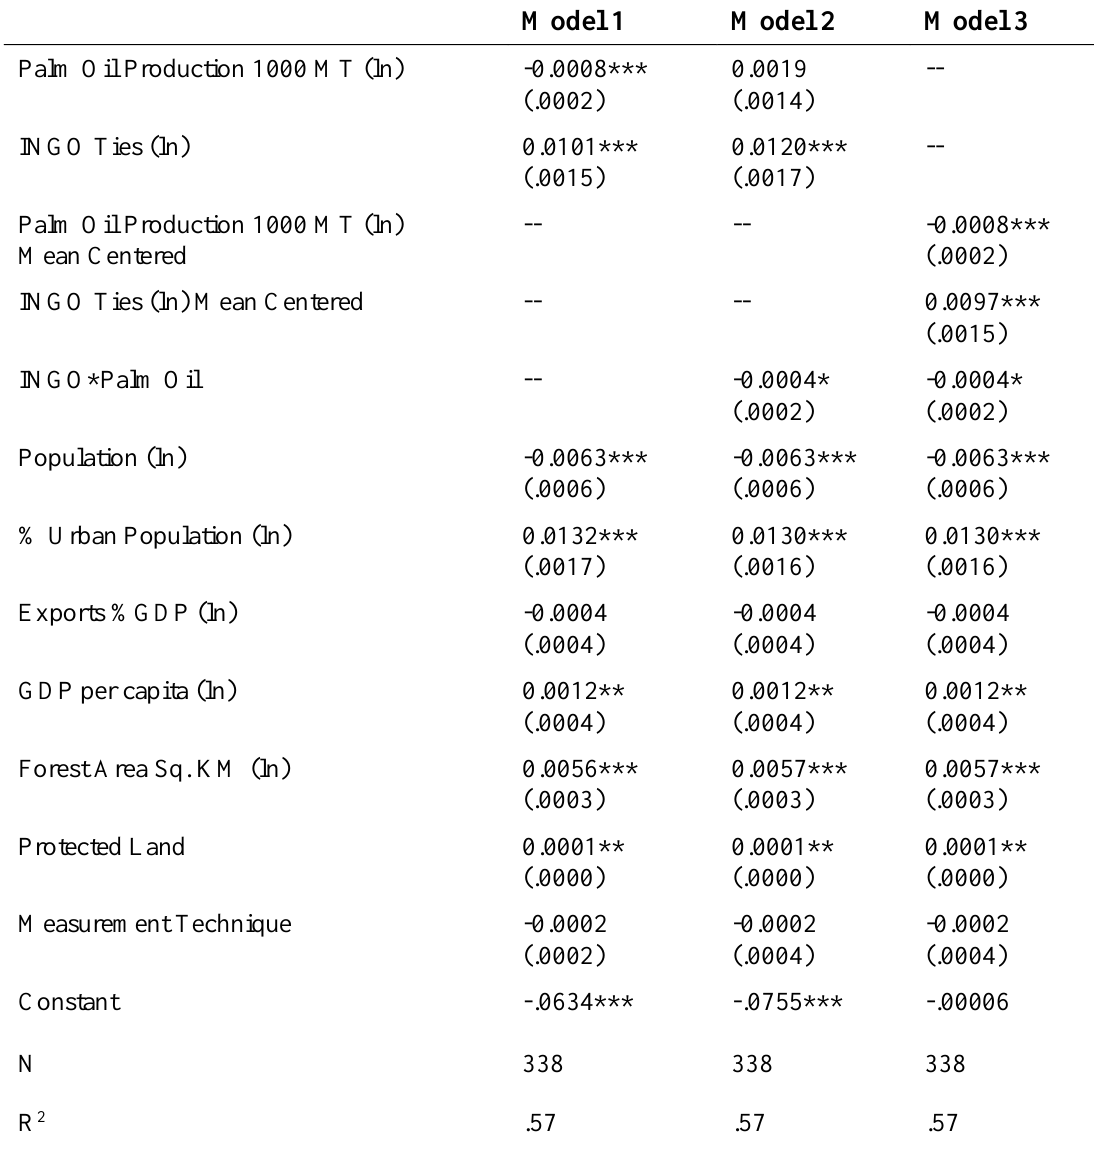
Table 3. Unstandardized Coefficients for Prais-Winston Regression Models of Primary Forest Area with AR[1]